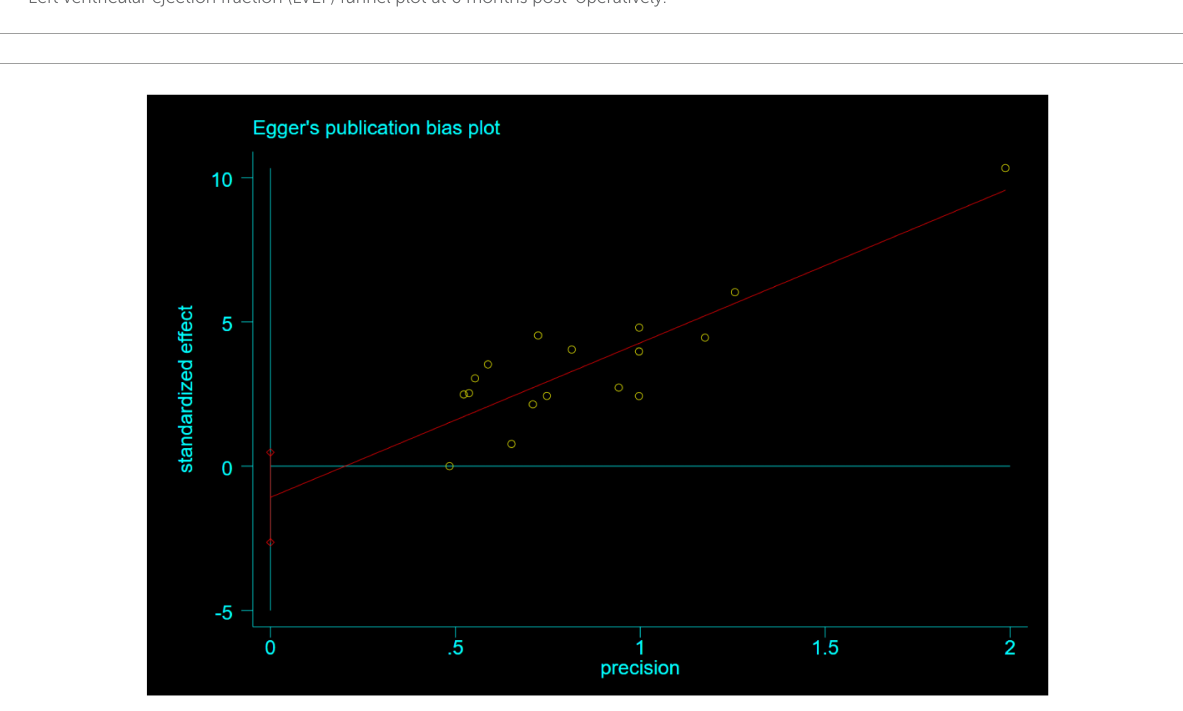
FIGURE9 Left ventricular ejection fraction (LVEF) egger’s test within 6 months after